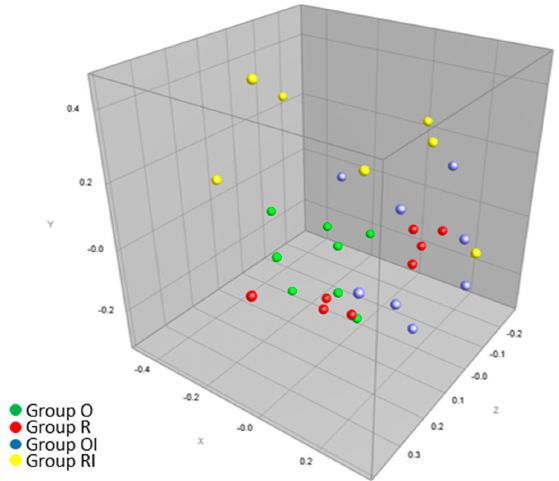
Figure 4. A three-dimensional MDS plot presenting the average similarities between the caecal microbiota of rats fed diets with the recommended (O, green dots) and decreased calcium levels (R, red dots) and supplemented with inulin (OI (blue dots) and RI (yellow dots), respectively). A multidimensional scaling analysis was preformed based on the similarity matrix generated during the composite data analysis of DGGE profiles of eubacteria, Bacteroides , Lactobacillus and C. leptum group bacteria.